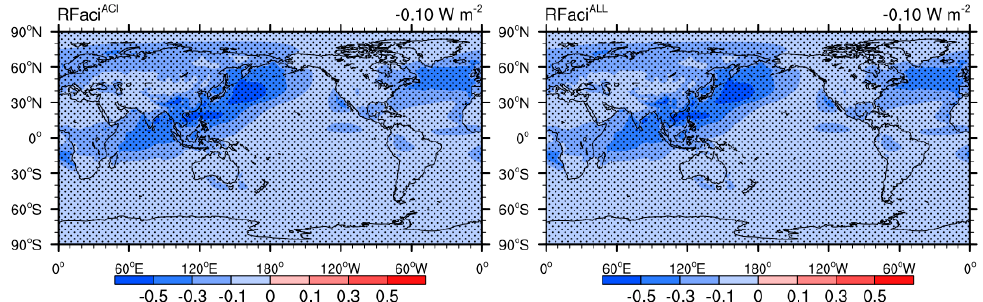
Figure 7. Instantaneous aerosol Twomey effect (RFaci) from the ACI (left) and ALL (right) experiments with the GAMIL model. The number on the top right of the figure denotes the ensemble average of global mean values. Differences significant at the 10% level of the Student’s t -test are depicted by dots.